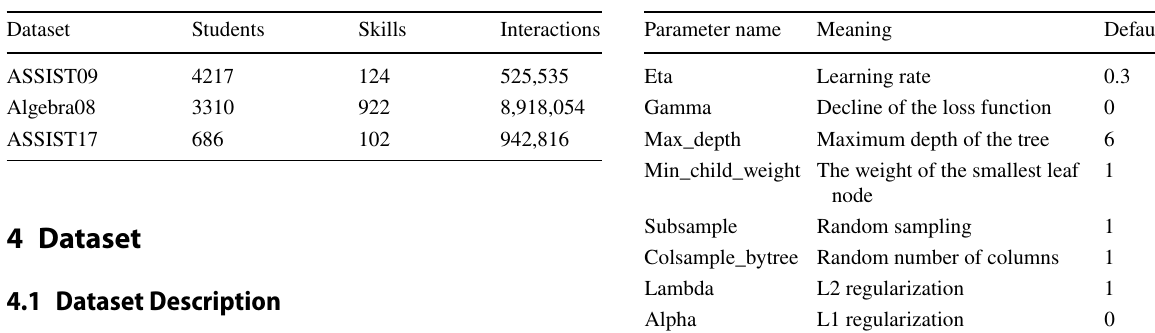
Table 2 The main parameters of XGBoost model